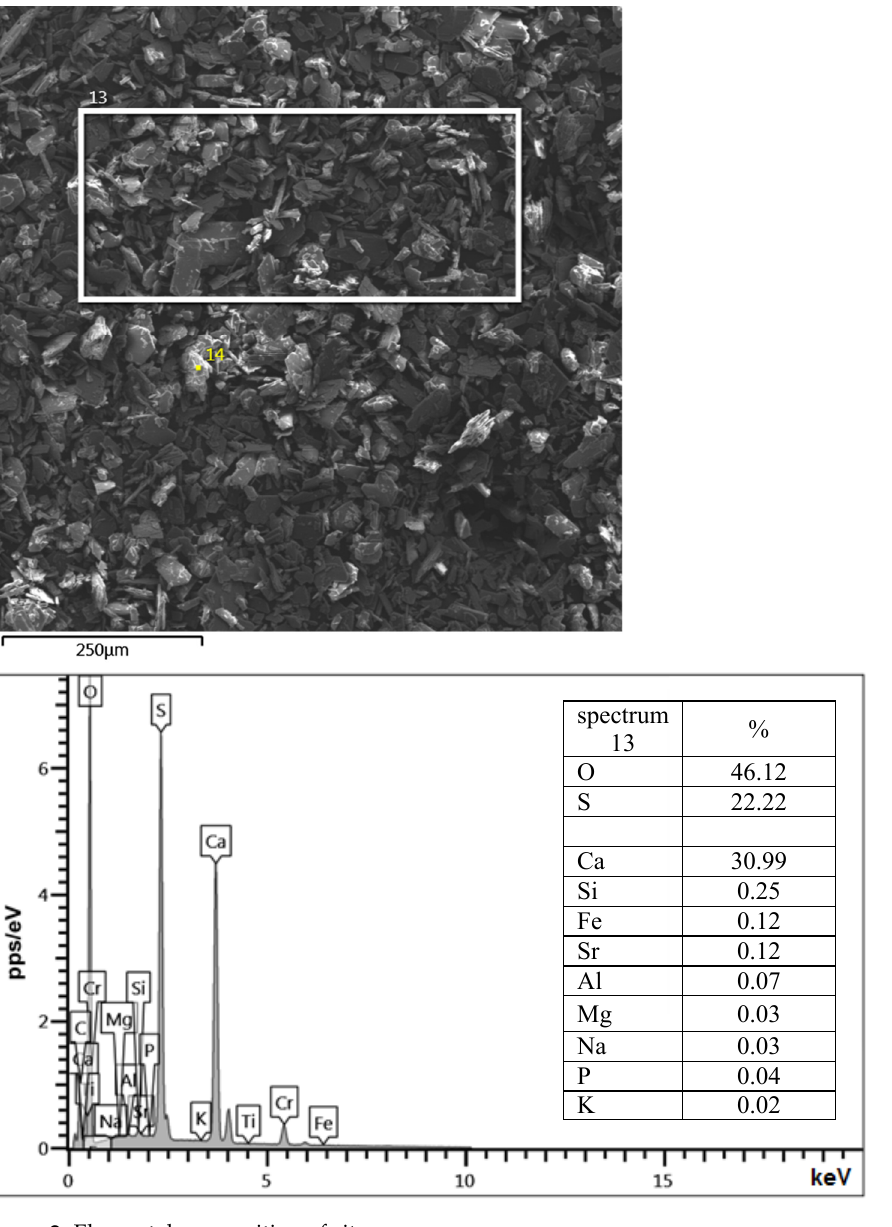
Figure 2. Elemental composition of citrogypsum . Table 1. Chemical composition of citrogypsum .